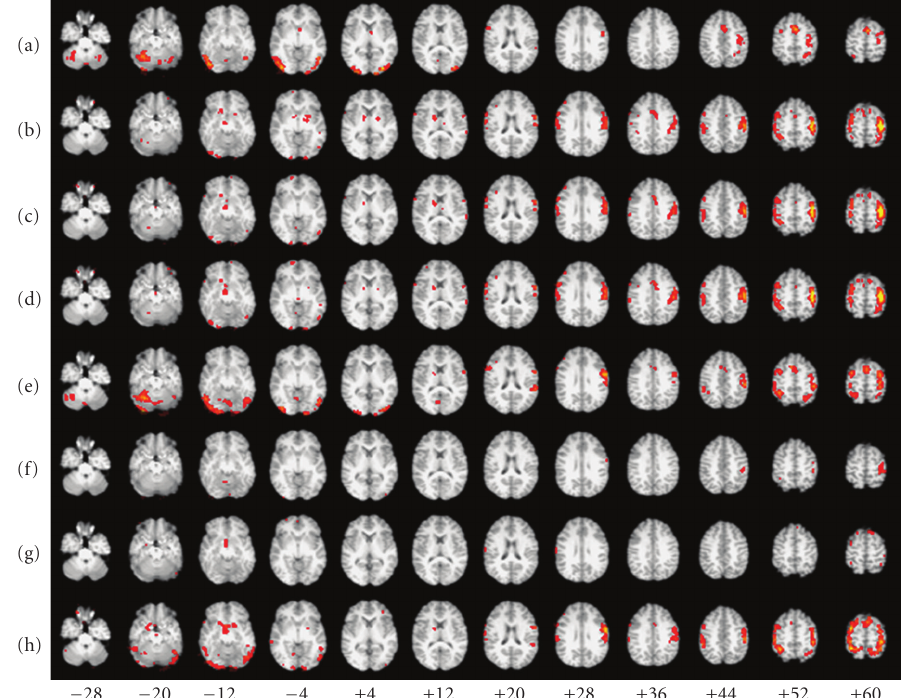
Figure 11: Spatial maps derived from Subject 8’s fMRI data using (a) task-related GLM; (b) single-voxel hybrid method (SV); (c) few-voxel hybrid method (FV); (d) many-voxel hybrid method (MV); (e) dual regression, single IC hybrid method (DRS); (f) dual regression, all IC hybrid method (DRA); (g) back-reconstruction with Infomax (BR-I); and (h) dual regression, single IC hybrid method, Infomax group IC seed source